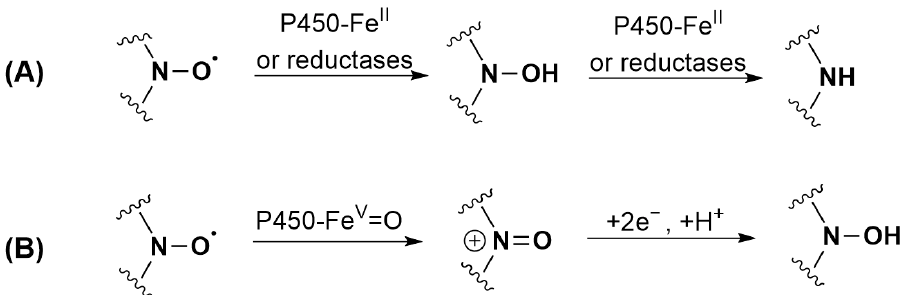
are observed with a delay of 0.2 min compared to the UV-Vis detection.